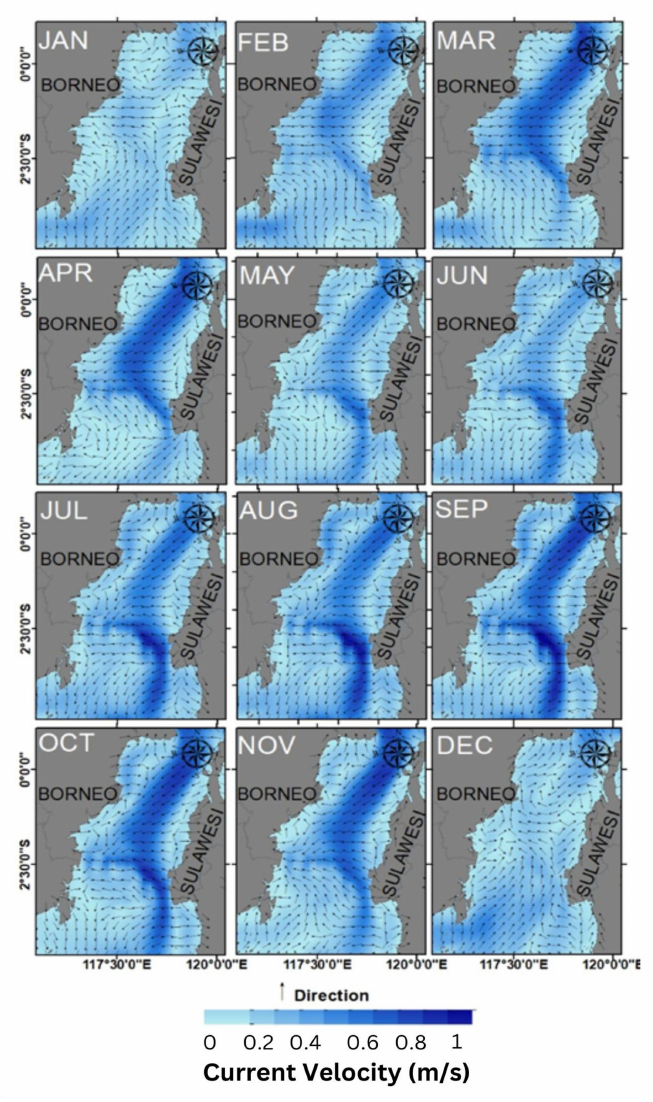
Figure 5. The Spatial Distribution Map of Average Current Direction and Velocity 2015–2020 in the Makassar